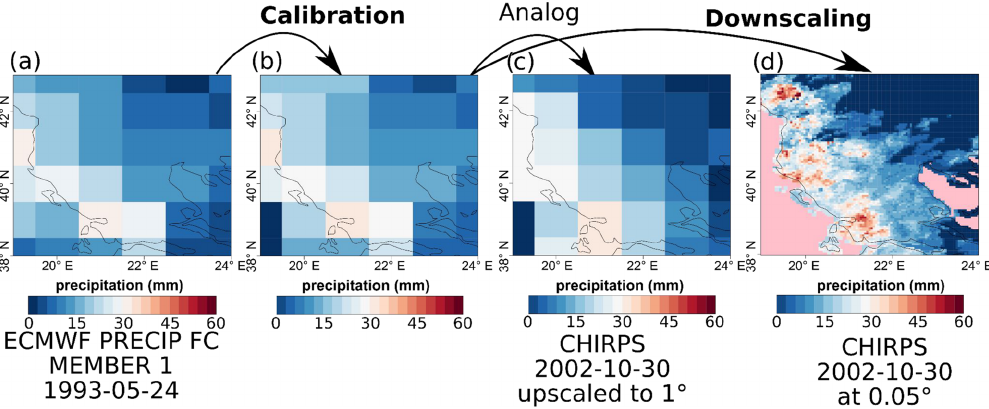
Figure 14. Comparison of the original forecast (a) , bias-adjusted forecast (b) , the analog (c) , and the downscaled (d) forecast over Greece for SEAS5 for 24 May